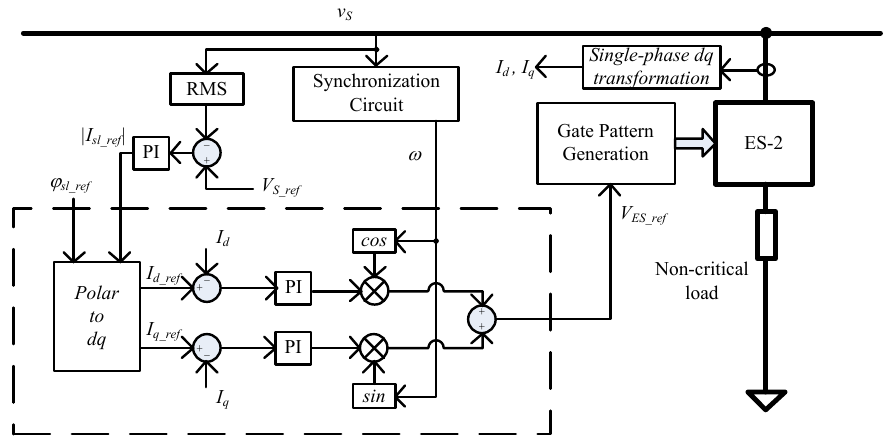
Figure 2. dq decoupling control with current controller [12].